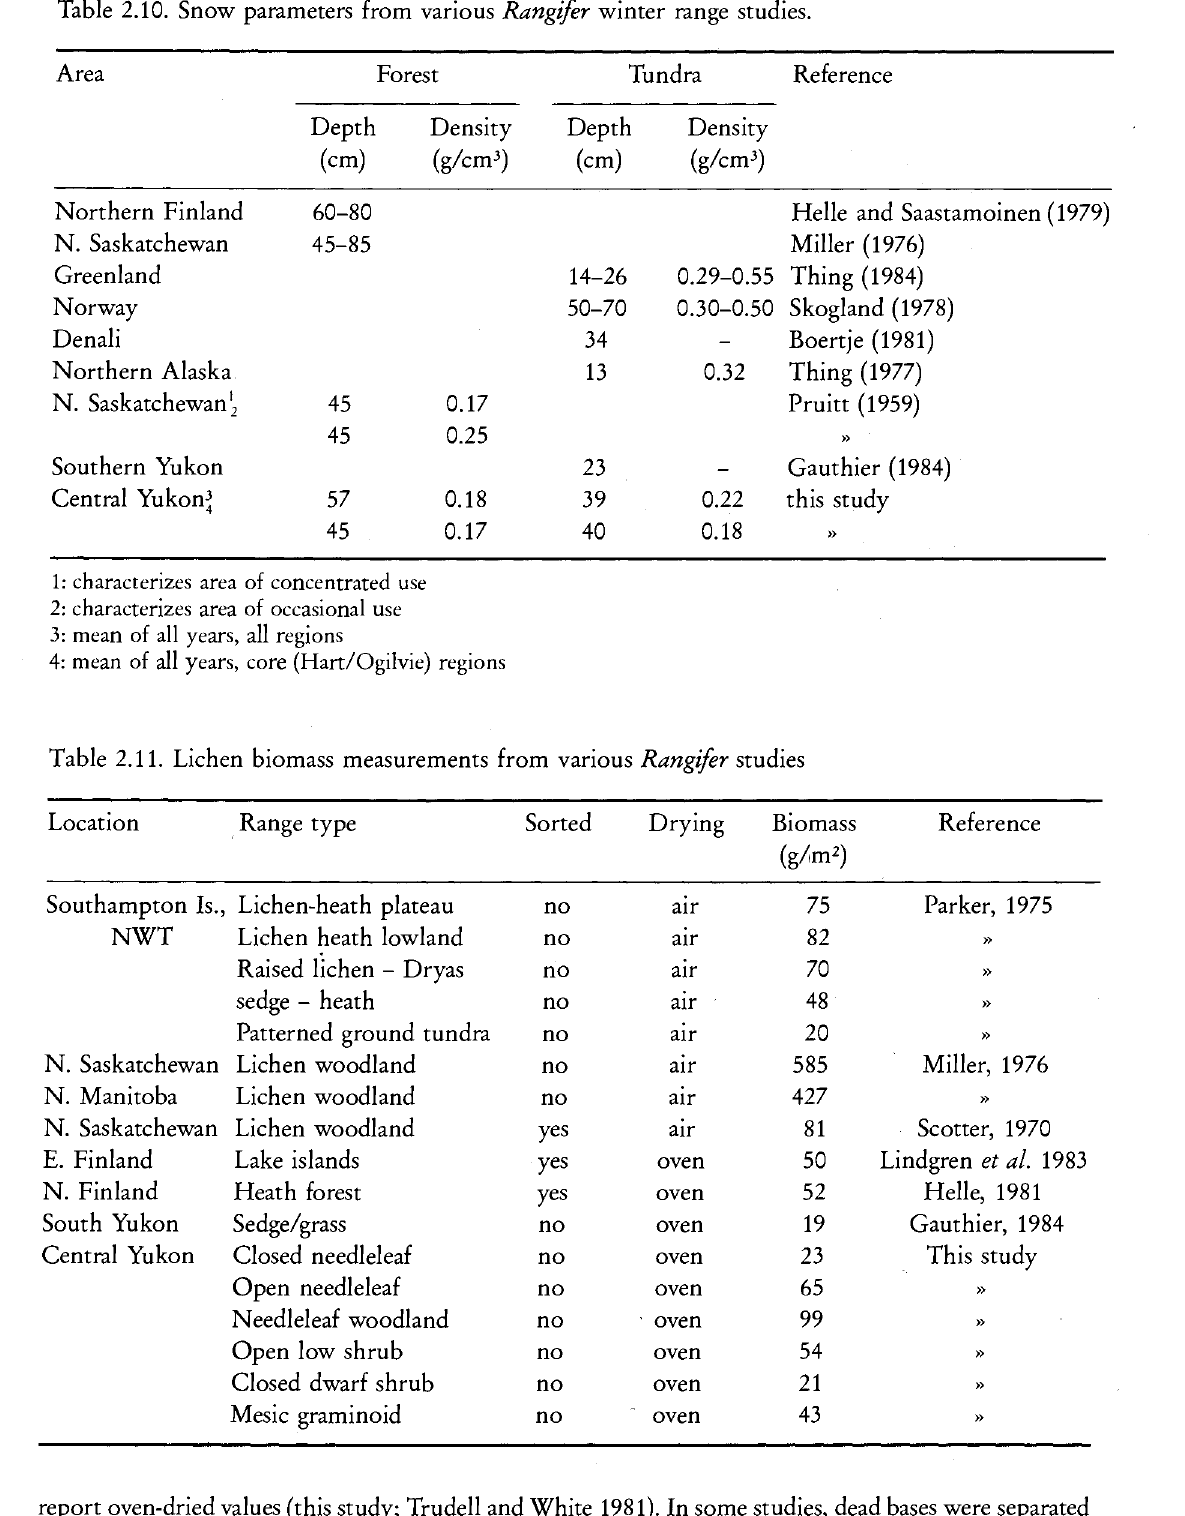
Table 2.11. Lich. zn biomass measurements from various Rangifer studies